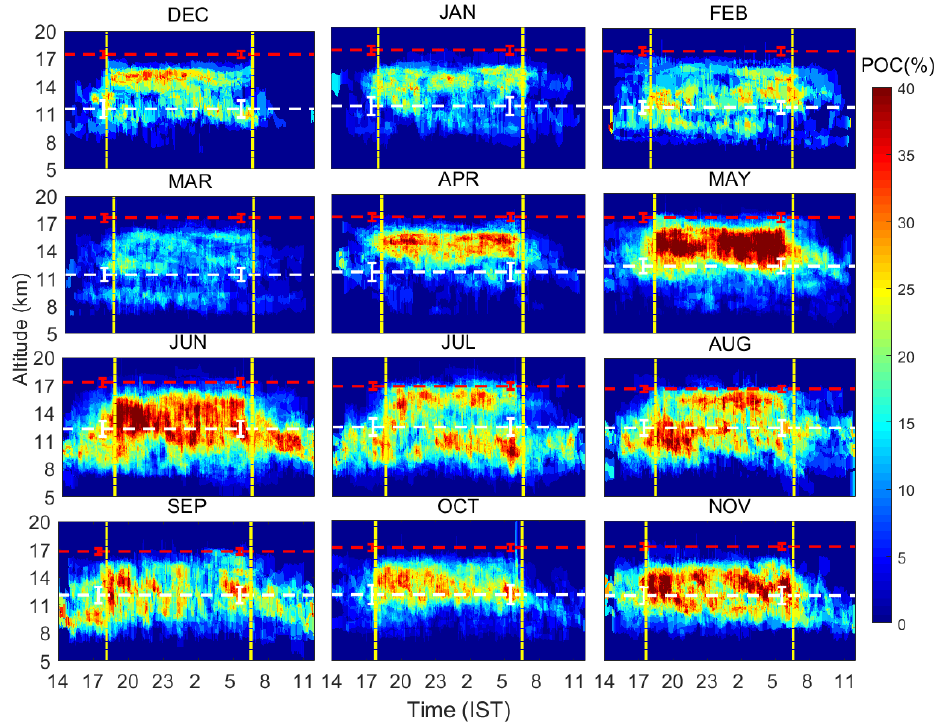
Figure 6. Monthly occurrence of cirrus clouds as a function of time and altitude from 2016 to 2018. The mean CPT (red line) and COT (white line) altitudes for the corresponding months are also embedded. The standard deviation of the CPT altitude at 17:30 and 05:30IST is also shown. Vertical dashed lines indicate the sunset and sunrise